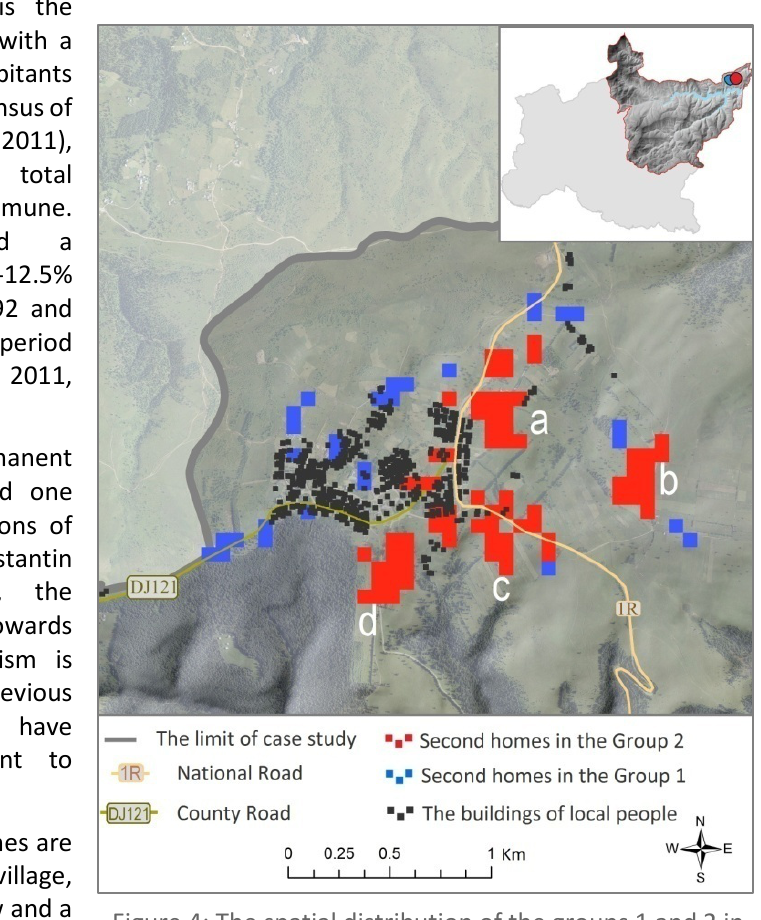
Figure 4: The spatial distribution of the groups 1 and 2 in the case of Beliș village (Beliș Commune, Cluj